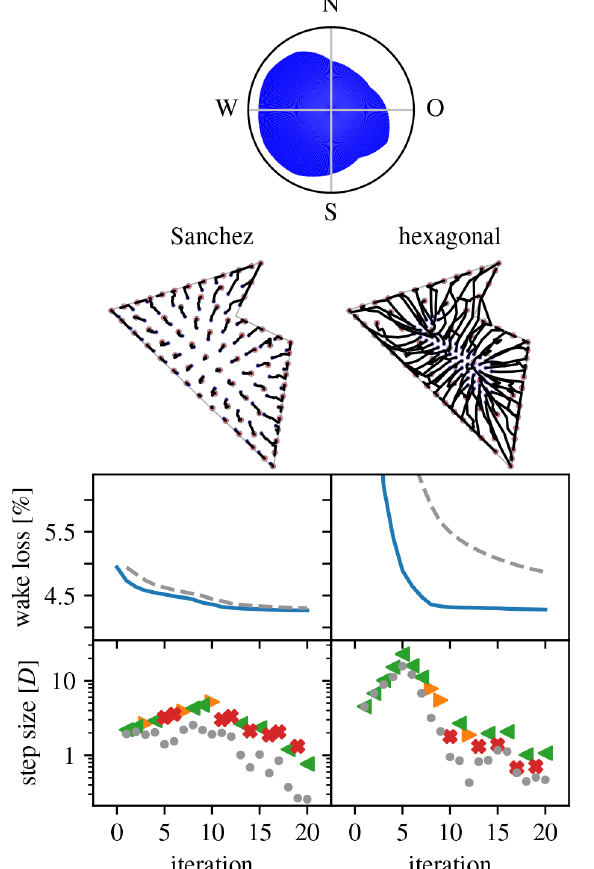
Figure 16. Overview of optimization runs for the Horns Rev wind farm layout problem. (Legend in Table 1.)